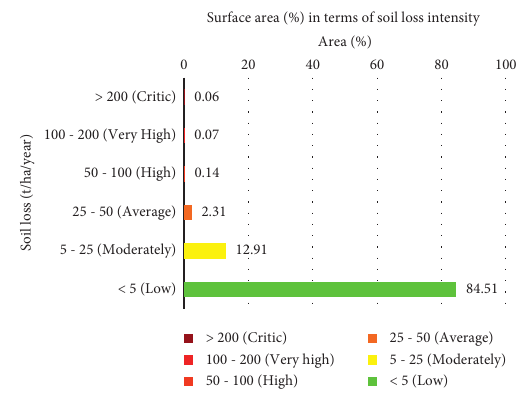
Figure 10: Surface area (%) in terms of soil loss intensity at the Beni Mohand River